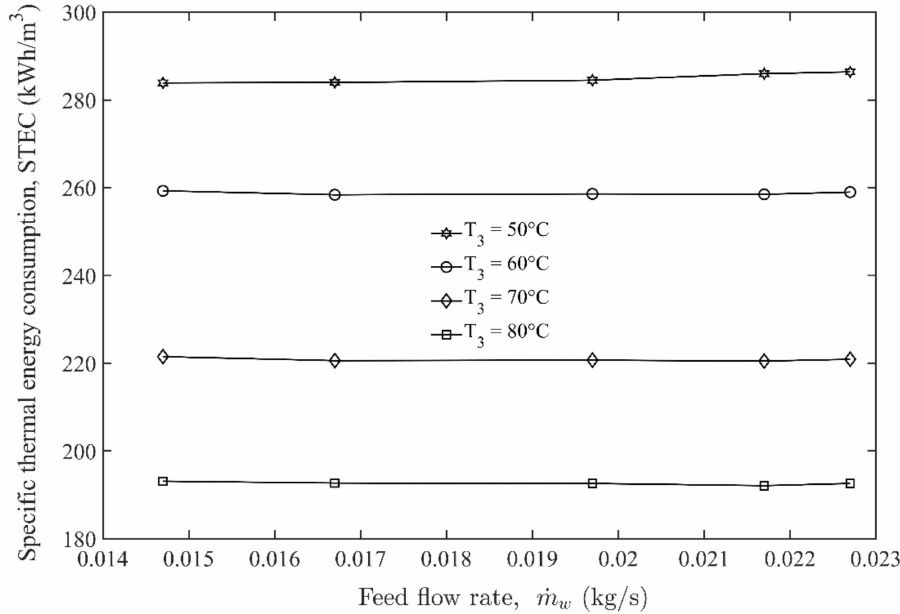
Figure 8. Specific thermal energy consumption in HDH at different feed water temperatures at humidifier